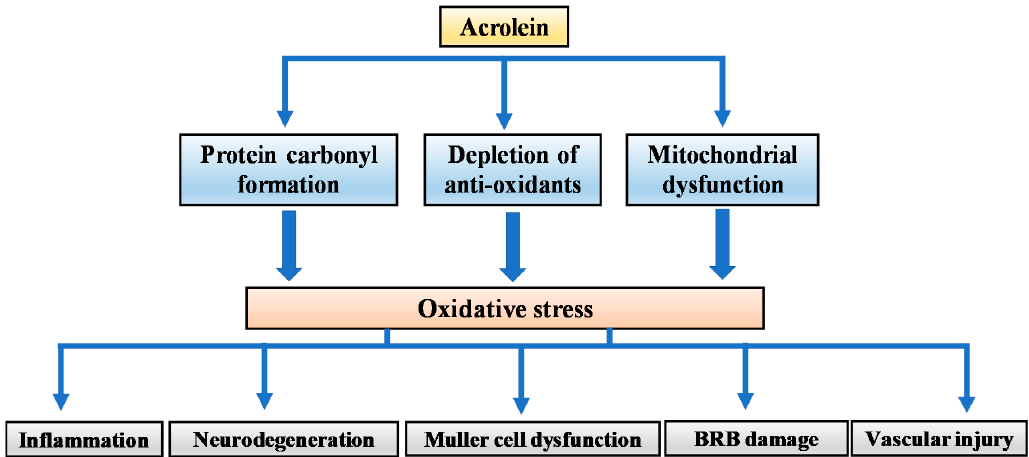
Figure 2. Schematic representation of the potential mechanisms of action of acrolein in the diabetic Figure2. retina.